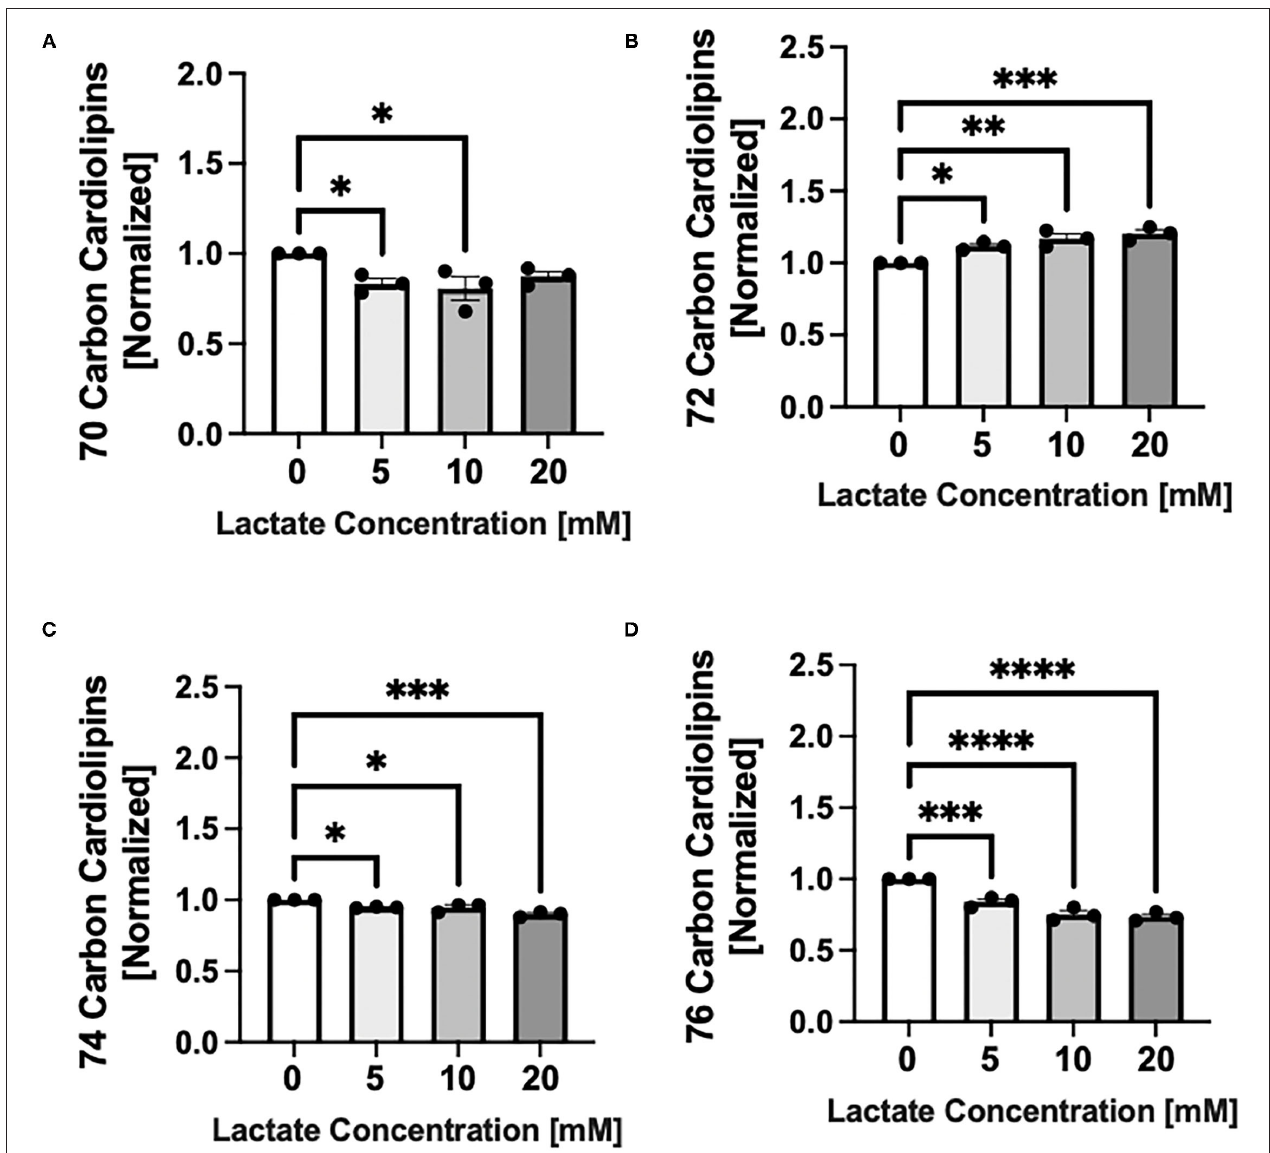
FIGURE 3 | Cardiolipin molecular species profile with chronic lactate treatment. NRVMs were treated for 48h with various concentrations of lactate and cardiolipin molecular profile assessed. Molecular species are expressed as a percent and size groups are normalized to the untreated sample from the same cell preparation day. Graphs show cardiolipin having total side chains lengths of (A) 70 carbons (untreated range from 9.5 to 10.0%), (B) 72 carbons (untreated range 40.2–49.3%), (C) 74 carbons (untreated range 27.2–29.2%) or (D) 76 carbons (untreated range 13.7–20.6%). n = average of 3 cell preparations; error bars show standard error of